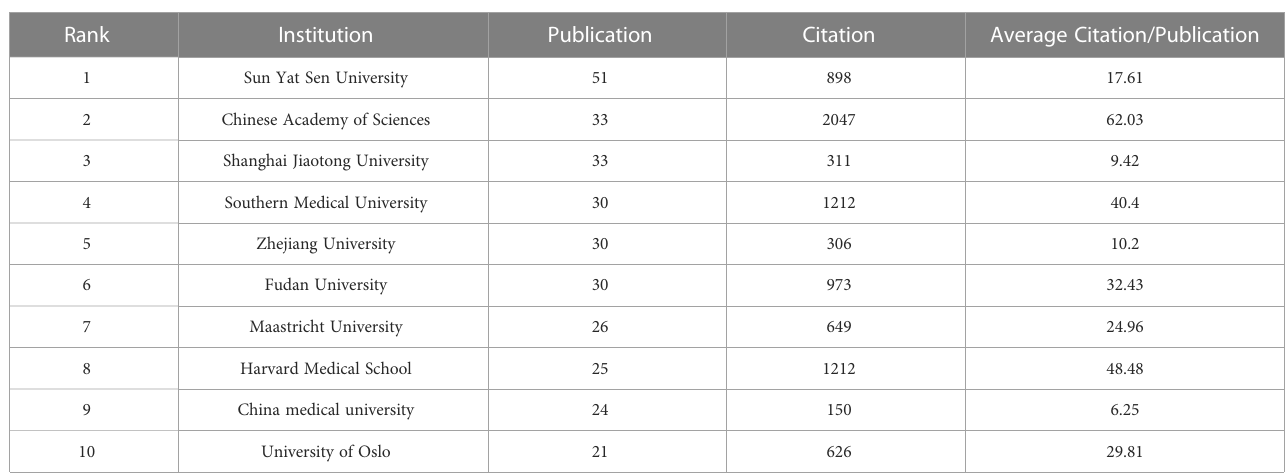
TABLE 4 Top 10 institutions with publications in AI in CRC.